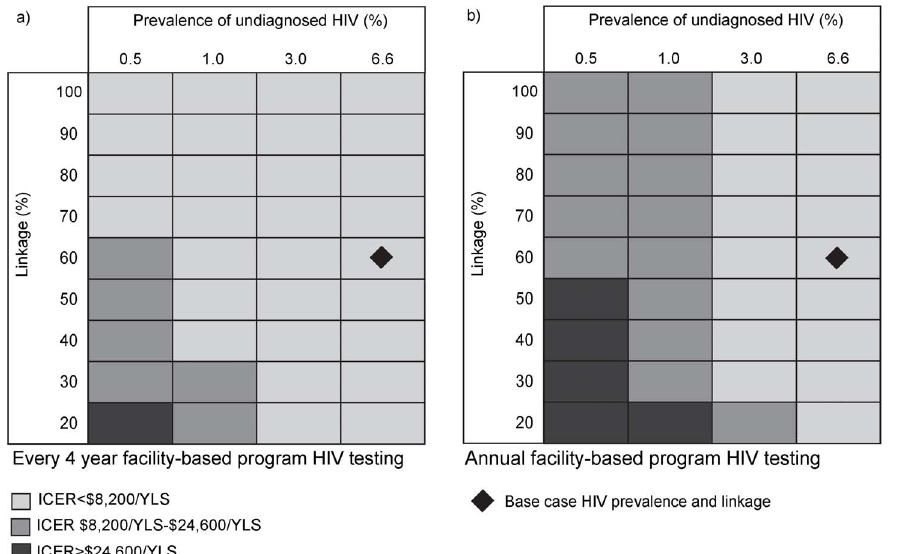
Figure 3. Multi-way sensitivity analyses on prevalence of HIV, linkage to care and facility-based HIV testing frequency. Prevalence of undiagnosed HIV is varied on the horizontal axis and linkage to care on the vertical axis. Figure a) represents the base case medical facility-based program HIV testing frequency of once every 4 years. Figure b) represents annual medical facility-based program HIV testing. Light gray represents scenarios with an incremental cost-effectiveness ratio (ICER) , 1 6 South African per capita gross domestic product ( $ 8,200), dark gray represents scenarios with an ICER $ 8,200/YLS to $ 24,600/YLS and black represents scenarios with an ICER . $ 24,600/YLS. HIV: human immunodeficiency virus, ICER: incremental cost-effectiveness ratio.